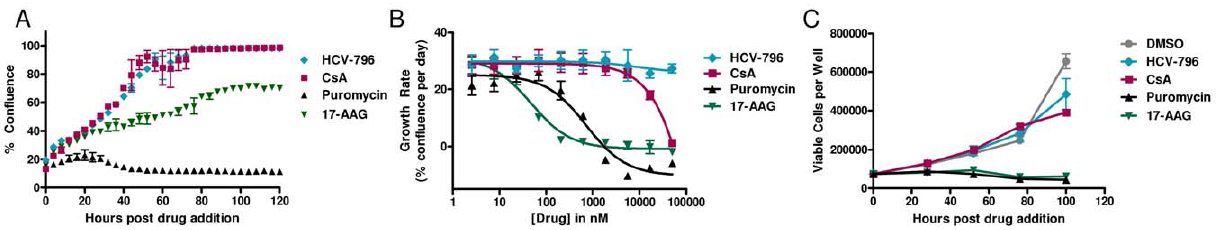
Figure 5. 17-AAG slows cellular growth at its effective antiviral concentration. (A) Cellular growth was determined by measuring the percent confluence (by microscopic quantification) every 4 hours. HCV-796 (blue diamonds), CsA (pink squares), puromycin (black triangles), 17-AAG (green triangles). (B) Growth rate (% confluence per day) as a function of compound dose. HCV-796 (blue diamonds), CsA (pink squares), puromycin (black triangles), 17-AAG (green triangles). (C) Trypan-blue exclusion was used to determine the number of viable cells each day post drug addition. HCV-796 (blue diamonds), CsA (pink squares), puromycin (black triangles), 17-AAG (green triangles), or an equivalent volume of DMSO (grey circles).